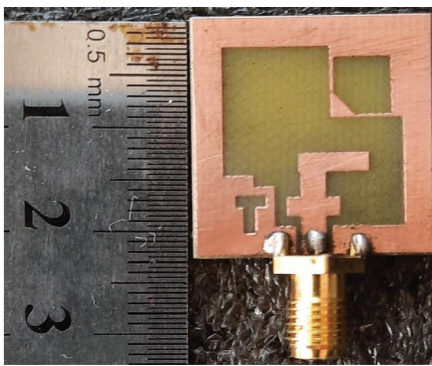
Figure 8: Fabricated antenna.